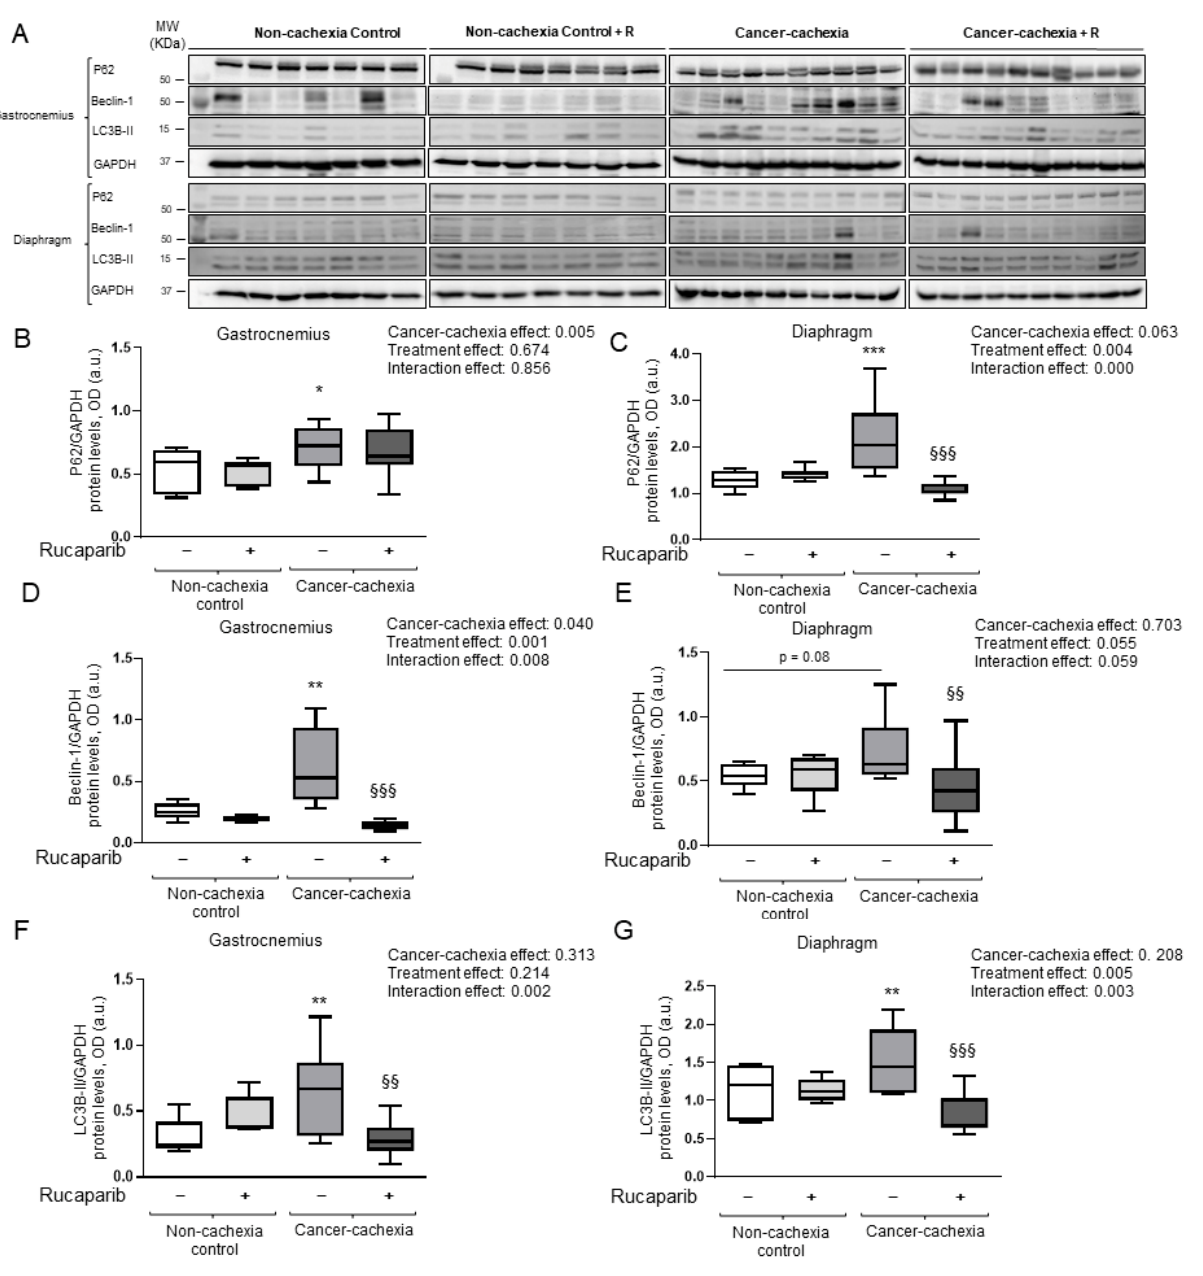
Figure 8. Immunoblots of p62, beclin-1, LC3B, and GAPDH proteins in the gastrocnemius and diaphragm muscles of all experimental groups of mice ( A ). Box plot representation of p62 protein levels in the gastrocnemius ( B ) and diaphragm ( C ) muscles of the different experimental groups of mice. Box plot representation of beclin-1 protein content in the gastrocnemius ( D ) and diaphragm ( E ) muscles of the different experimental groups of mice. Box plot representation of LC3B-II protein levels in the gastrocnemius ( F ) and diaphragm ( G ) muscles of the different study groups of mice. Abbreviations: LC3B, microtubule-associated protein 1 light chain 3B; p62, nucleoporin p62; GAPDH, glyceraldehyde-3-phosphate dehydrogenase; MW, molecular weight; kDa, kilodalton; OD, optical densities; a.u., arbitrary units; − , untreated with rucaparib; +, treated with rucaparib. Statistical significance: * p ≤ 0.05, ** p ≤ 0.01, and *** p ≤ 0.001 between the untreated non-cachexia controls and the non-treated cancer cachexia mice; §§ p ≤ 0.01 and §§§ p ≤ 0.001 between the cancer cachexia mice treated with rucaparib and the non-treated cancer cachexia mice. Two-way ANOVA significance ( p value) of cancer cachexia and treatment and interaction effects are also shown for each variable. Uncropped WB images were shown in Figure